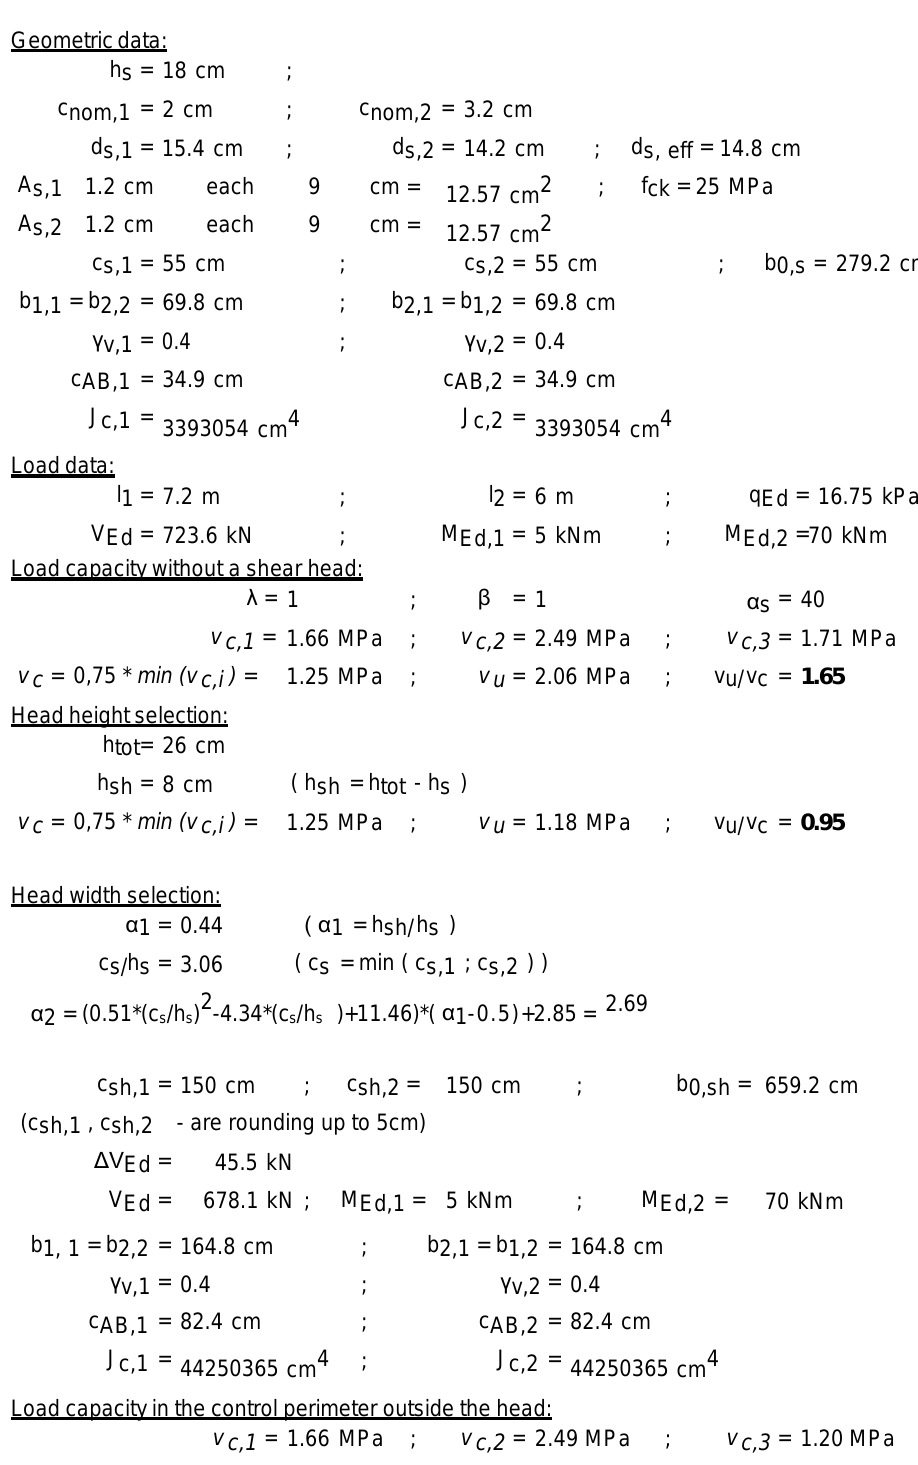
Figure A7. Verification example no. 3—ACI 318.